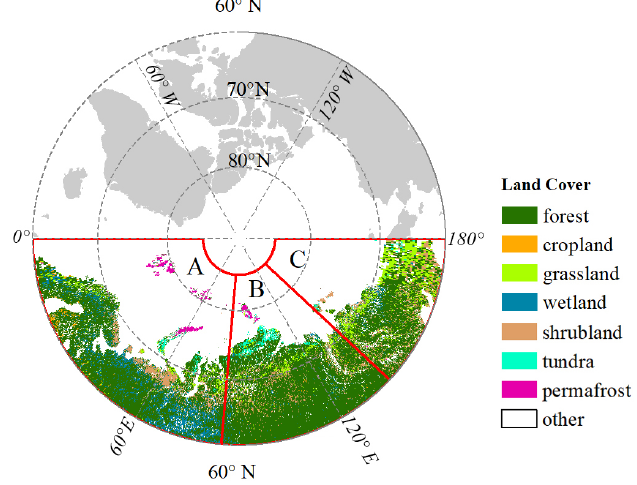
Figure 1. The Subarctic study area and the three regions. Data source: ESA Land Cover Data. A is the East European and West Siberian Plain; B is the Central Siberian Plateau; C is the East Siberian Highlands.